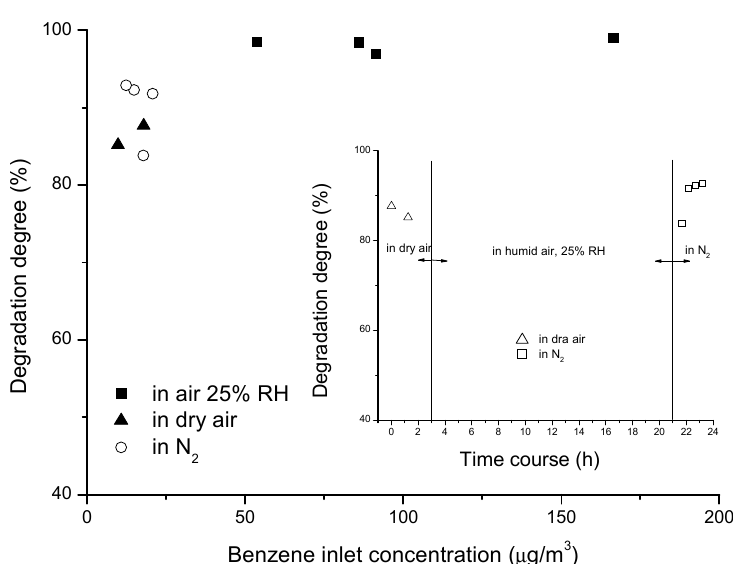
Figure 3. Degrees of degradation versus benzene inlet concentration in humid air (25% relative humidity), dry air (bottle air), and N 2 .